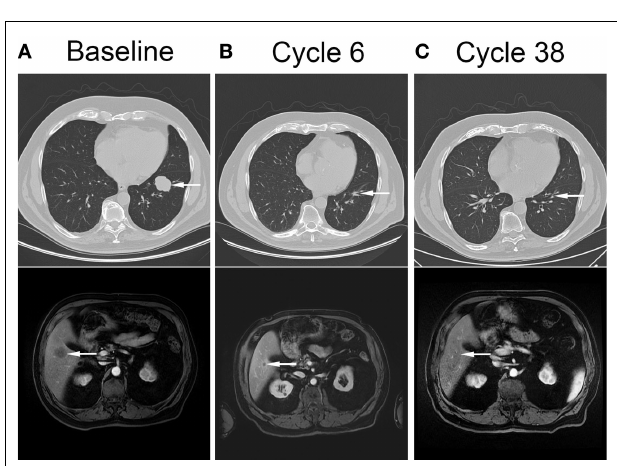
FIGURE 2 | Complete resolution of metastatic disease in response to cytotoxic therapy and veliparib . Computed tomography images showing pulmonary (top panel, arrow) and liver (bottom panel, arrow) metastases at baseline (A) , after completion of cytotoxic therapy and veliparib (B) , and after 38 cycles of veliparib maintenance therapy (C)